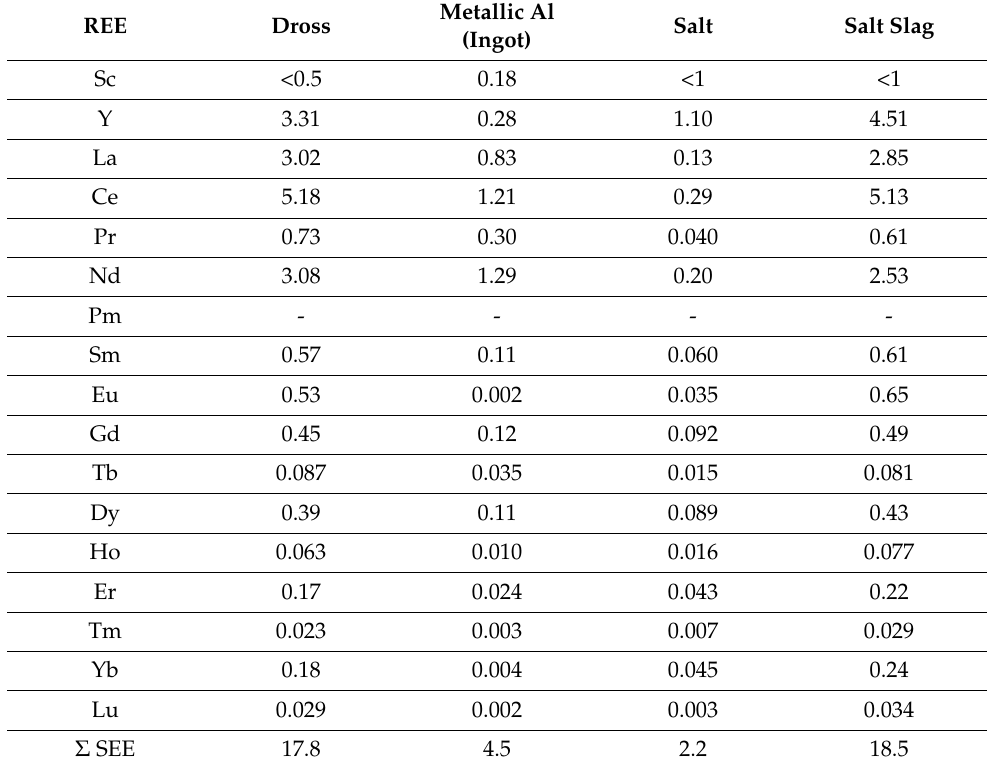
Metallic Al Salt Salt Slag (Ingot)